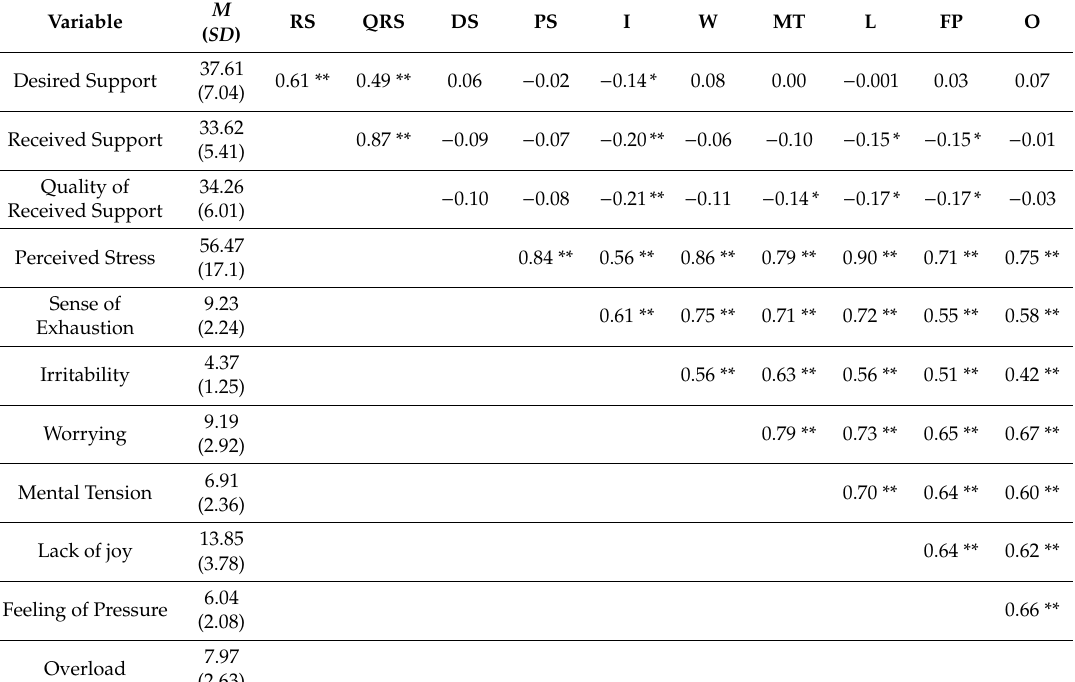
Table 5. Pearson’s linear correlation coe ffi cient for social support and mother’s perceived stress and its